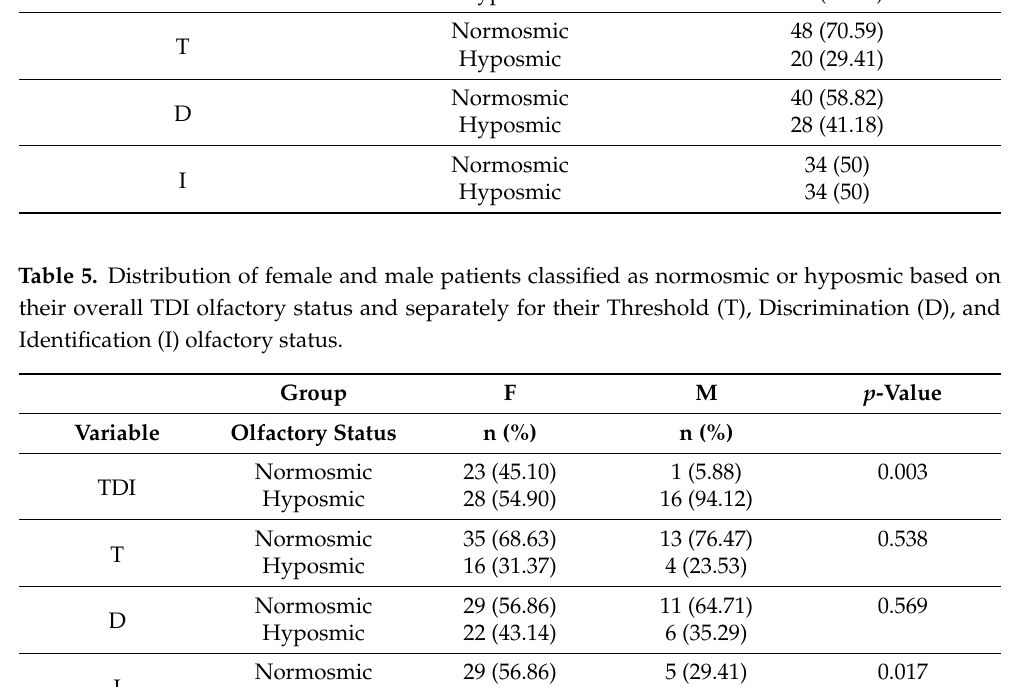
Table 4. Distribution of patients classified as normosmic or hyposmic based on their overall TDI olfactory status and singly for their Threshold (T), Discrimination (D), and Identification (I) olfactory status. Variable Olfactory Status TDI